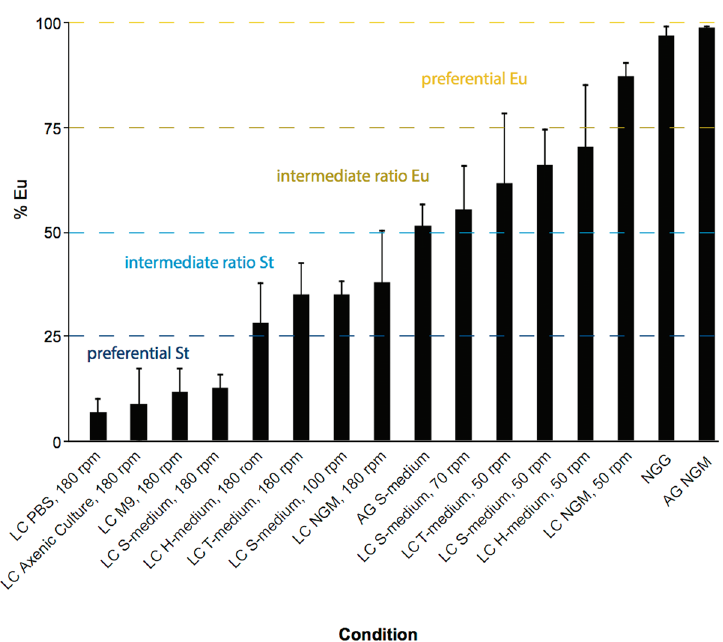
Figure 3. Comprehensive evaluation of culture method on mouth-form ratio in P . pacificus . Same data as in Table 1, but presented according to gradation of effect on mouth-form phenotype, from low to high % eurystomatous. LC = liquid culture, AG = agar, T and H medium = S-medium with phosphate replaced with 50 mM Tris or HEPES, pH 7.5, respectively, NGG = NGM with agar replaced with Gelrite/Gelzan CM (Sigma) 35 . Error bars represent standard error mean (SEM) for different biological replicates ( n ≥ 3,